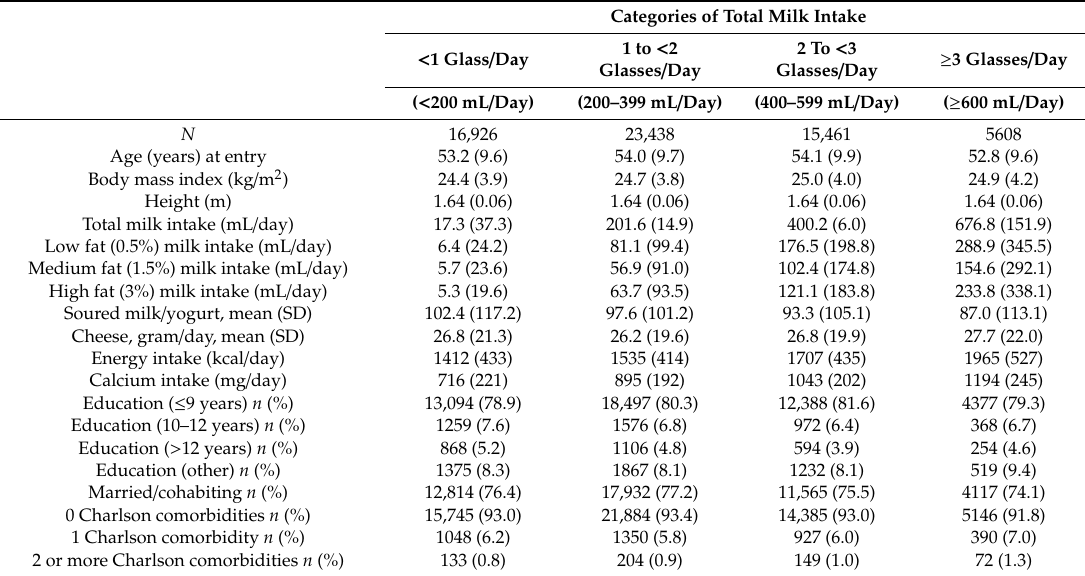
Table 1. Baseline characteristics of the women in the Swedish Mammography